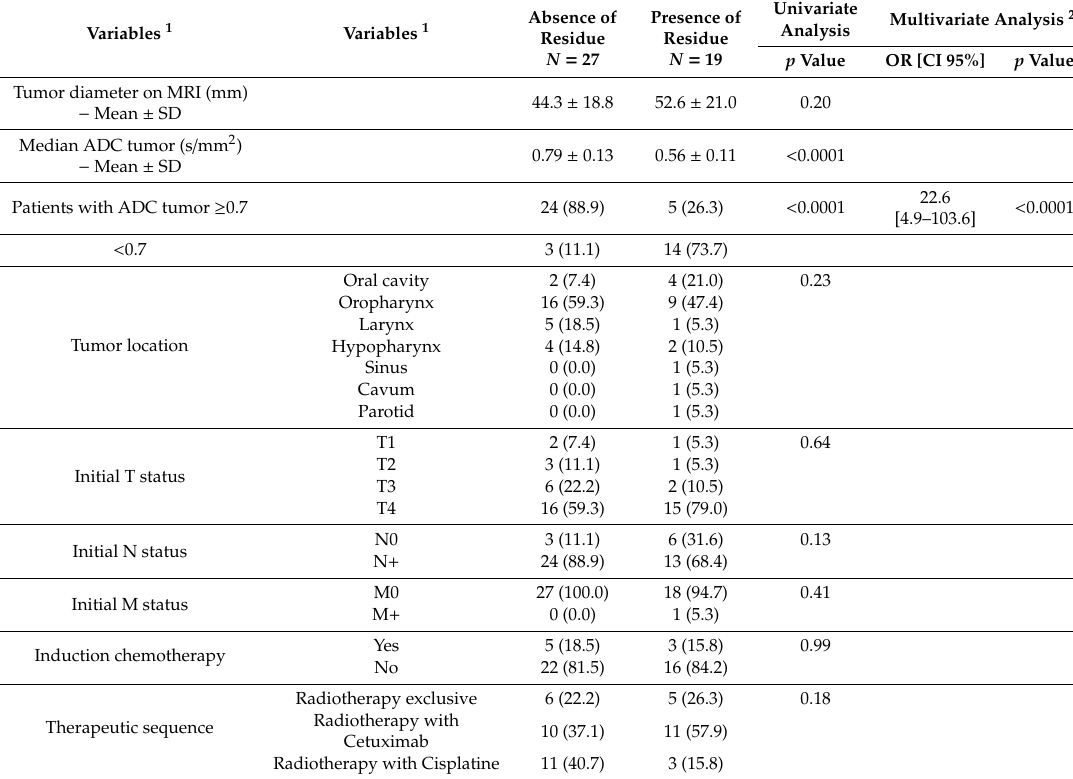
Univariate Presence of Absence of Analysis Residue Residue N = 19 N = 27 p Value